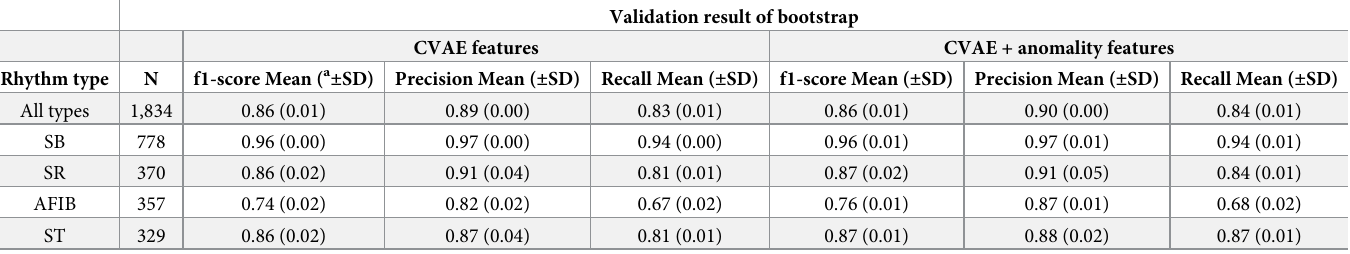
Table 3. Transfer learning using CVAE features and anomality